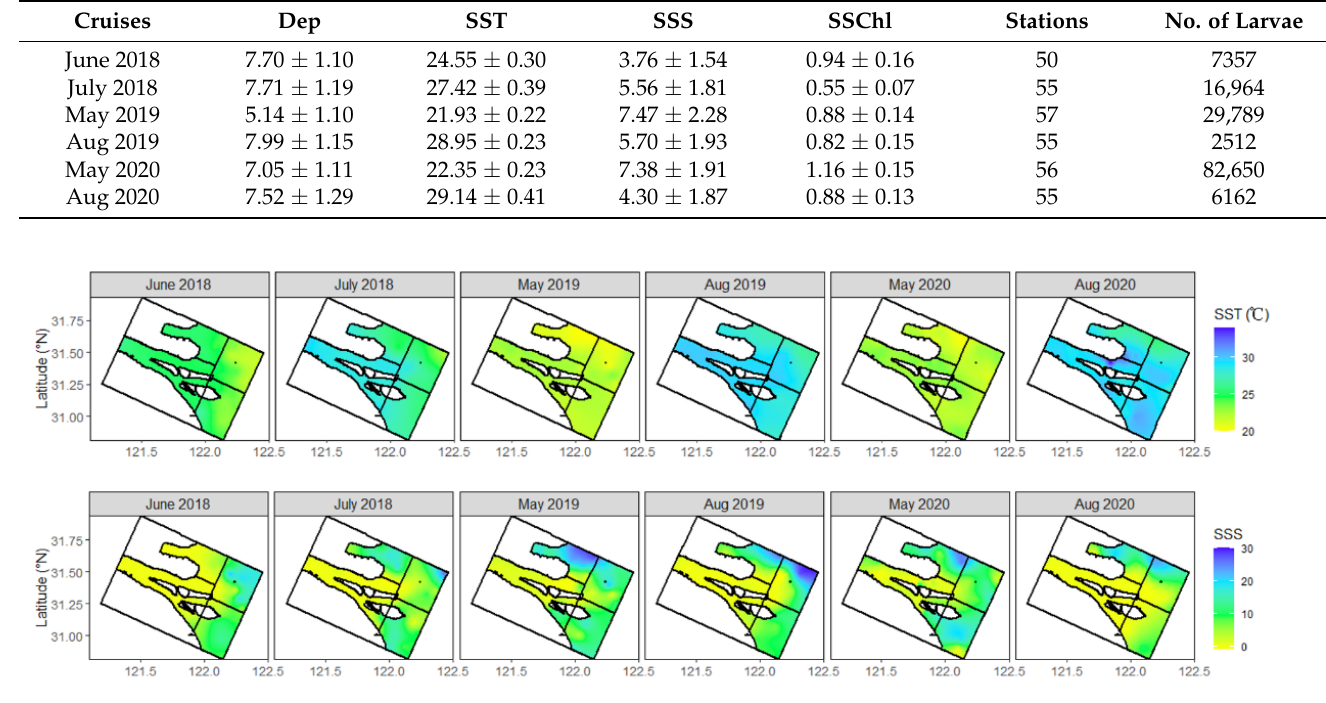
Figure 4. The distribution of environmental factors in the Yangtze Estuary (SST, sea surface temper- ature; SSS, sea surface salinity; SSChl, sea surface chlorophyll a). Table 1. Mean values for depth (Dep, m), sea surface temperature (SST, °C), sea surface salinity (SSS), and sea surface chlorophyll a (SSChl, mg/m 3 ) sampled during six cruises in the Yangtze Estu- ary (±95% confidence interval).